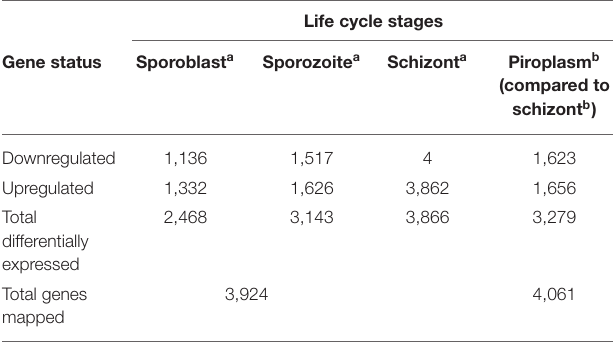
TABLE 6 | Number of T. parva genes differentially expressed in the tick vector and bovine